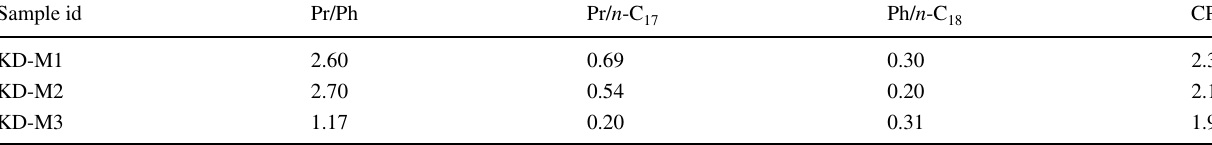
and isoprenoids, atomic ratios, huminite/vitrinite reflectance (VR o %) and maceral counting percentage along with basis of mineral matter (vol.%) and mineral-matter-free